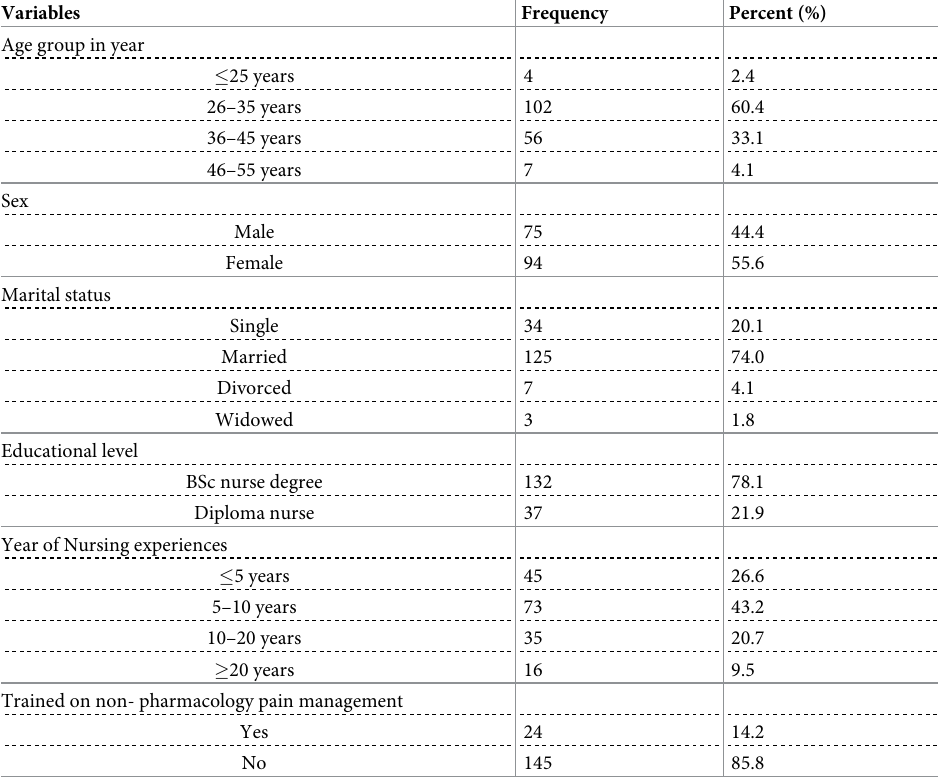
Table 1. Sociodemographic characteristics of nurses working in Debre Tabor Comprehensive Specialized Hospi- tal, Ethiopia, 2020.